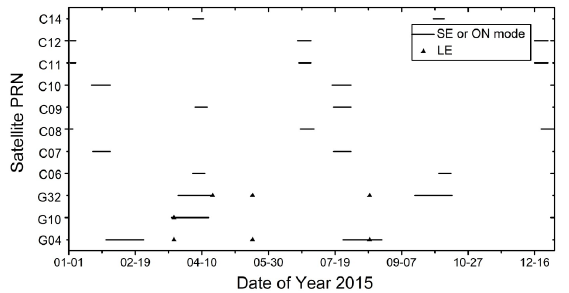
Figure 3. Data deleted from Block-IIA (G04, G10 and G32) in eclipse season and BeiDou Navigation Satellite System (BDS) satellites in orbit-normal (ON) mode (SE represents solar eclipse and LE represents lunar eclipse).